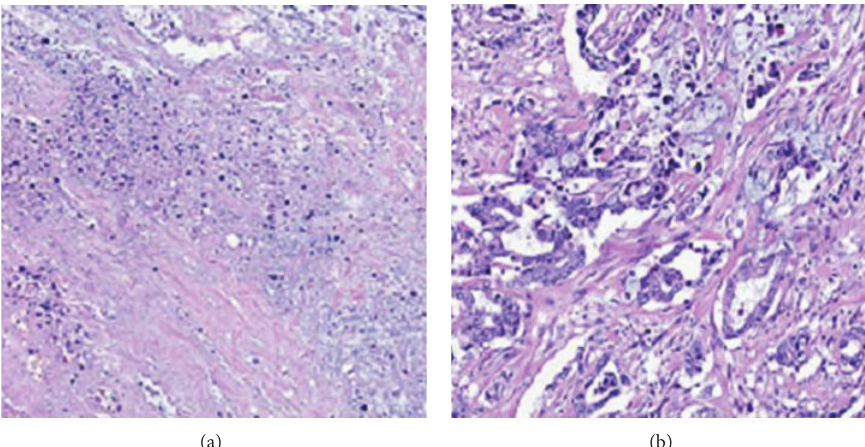
Figure 9: H&E staining of pancreatic cancer after HIFU ablation shows (a) disappearance of nuclei and necrosis and (b) the thermally fixed cancer cells (used with permission